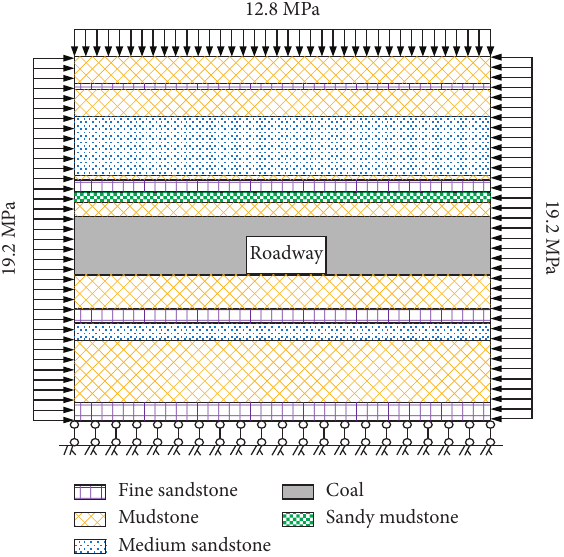
Figure 2: Geological section of the south wing general return